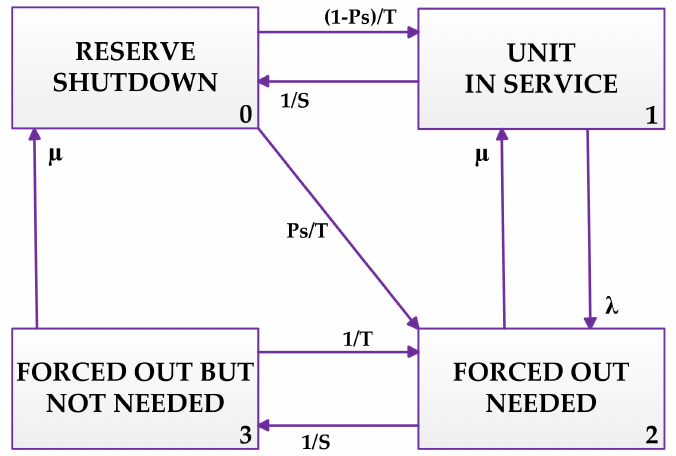
Figure 4. Four-state model for peaking and cycling load